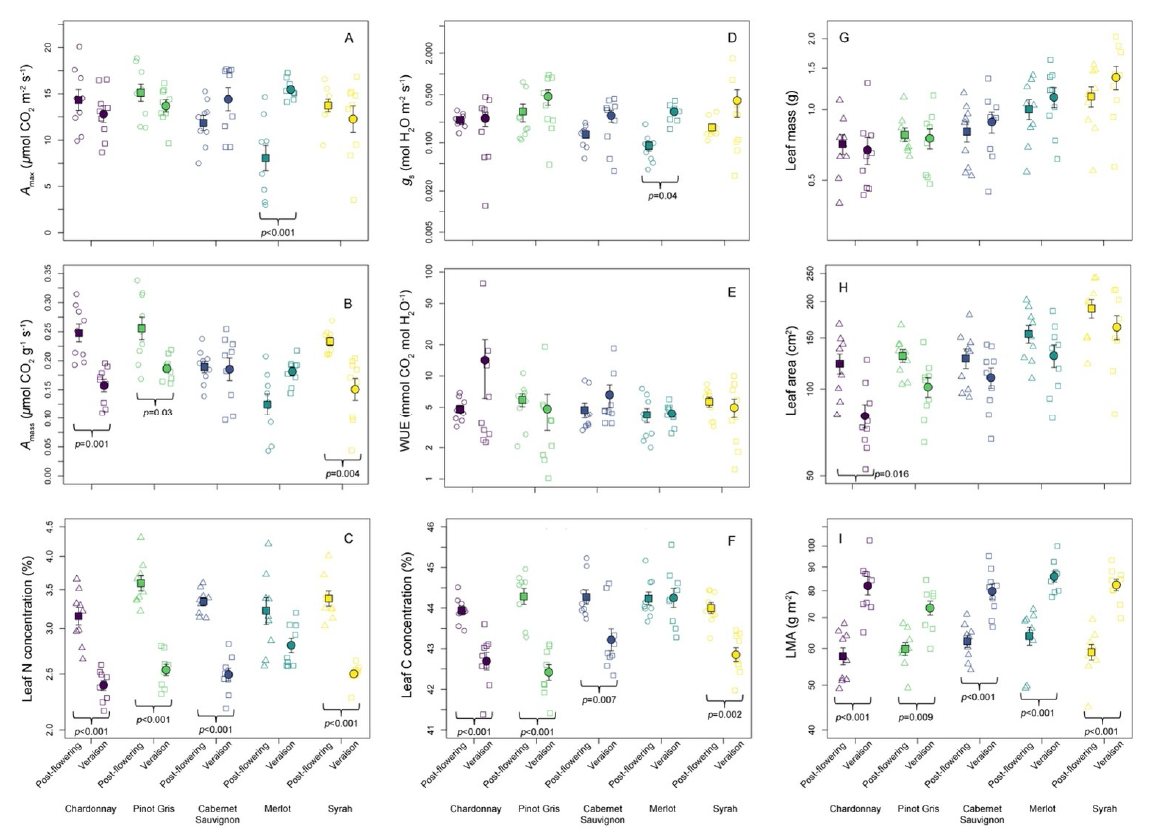
Figure 1. Functional trait variations across five wine grape varieties at two growth stages. Colours correspond to different wine grape varieties, with square symbols representing trait values measured post-flowering and circles representing trait values measured during veraison. Trait data are presented on log-scales where appropriate, as informed by the summary statistics presented in Table 1, and results from analyses of variance (ANOVAs), testing for differences in traits across varieties, growth stage, planting rows, and all interactions, are presented in Table 2. Additionally, certain results are presented from Tukey’s honestly significant difference (HSD) post hoc tests. For clarity, only instances where traits varied significantly within varieties across growth stages (Tukey’s HSD p < 0.05) are shown below a given contrast. Trait abbreviations are as follows: A max : light saturated maximum photosynthetic rate on a per-unit leaf area basis (Panel A ); A mass : light saturated maxi- mum photosynthetic rate on a per-unit leaf mass basis (Panel B ); leaf N: leaf nitrogen concentration (Panel C ); g s : stomatal conductance (Panel D ); WUE: instantaneous water use efficiency (Panel E ); leaf C: leaf carbon concentration (Panel F ); leaf mass: leaf dry mass (Panel G ); leaf area: fresh leaf area (Panel H ); LMA: leaf mass per unit area (Panel I